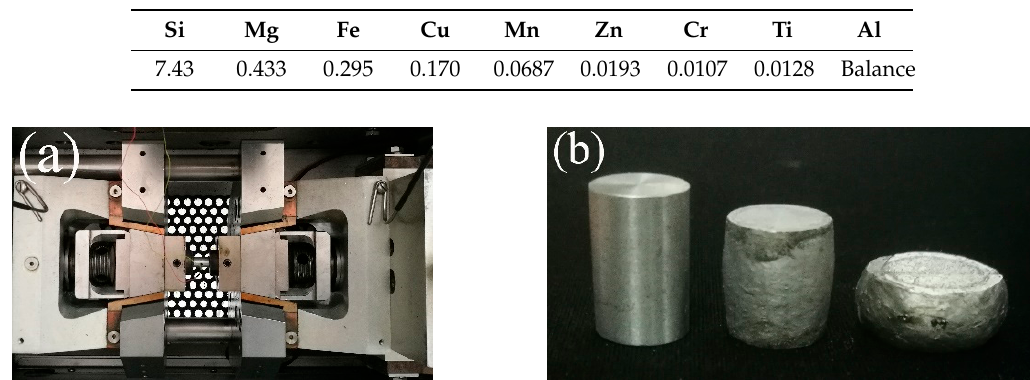
Figure 1. ( a ) The test setup and ( b ) the specimens before, during and after the tests.